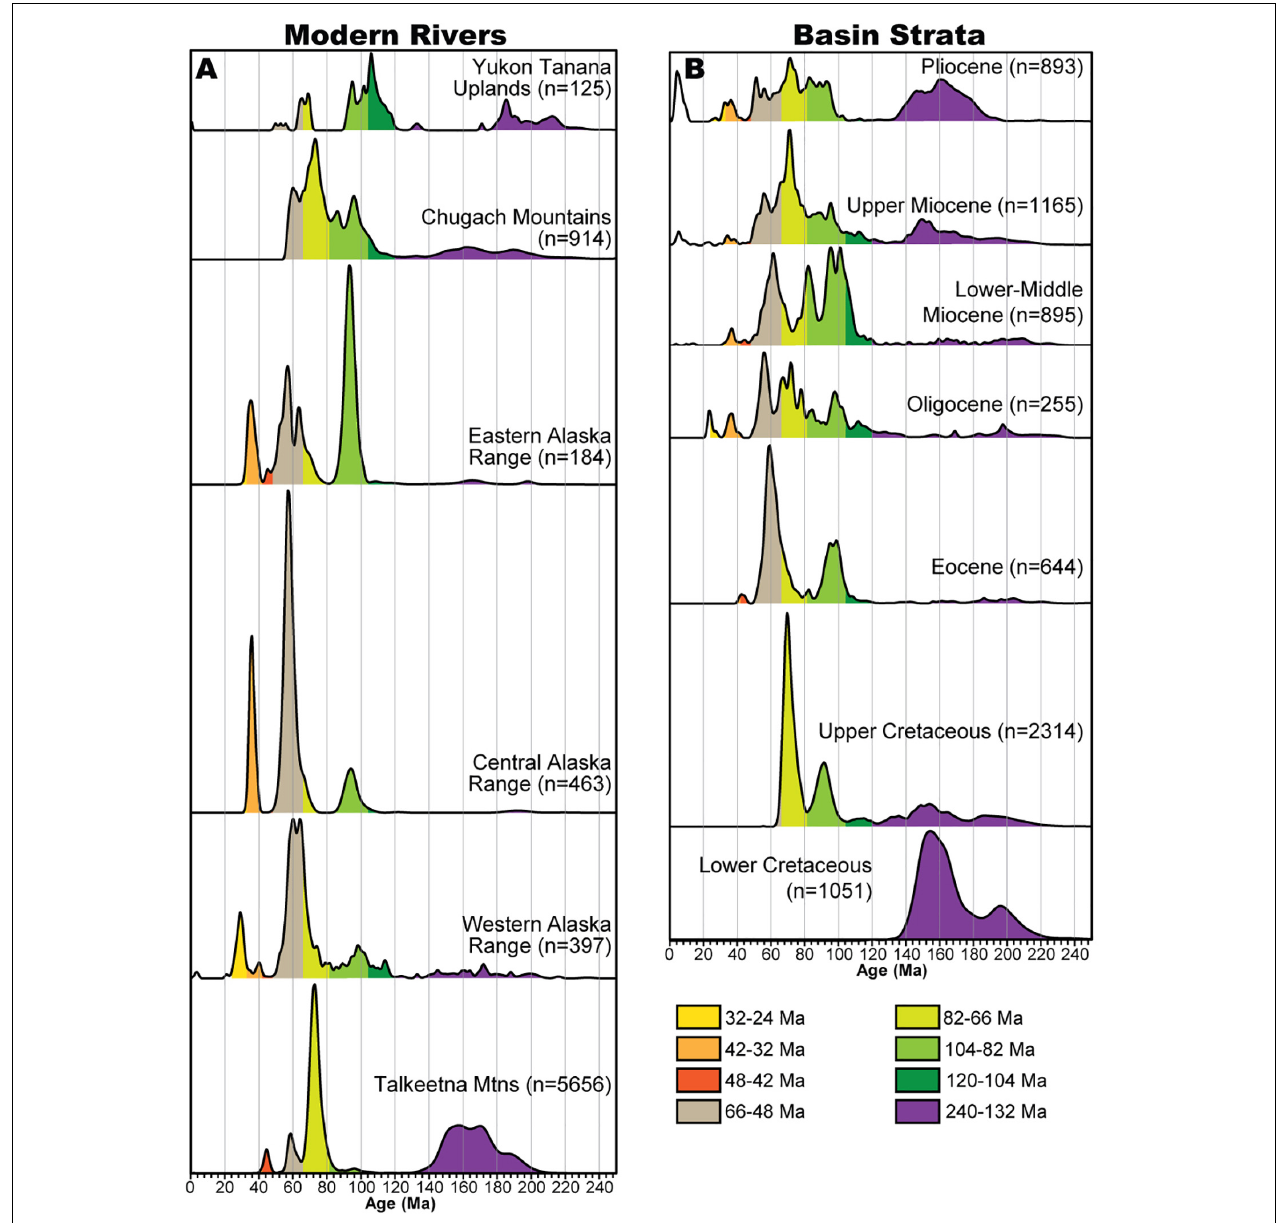
FIGURE 2 | Probability density plots of geochronological data from (A) potential source regions and (B) forearc basinal strata.